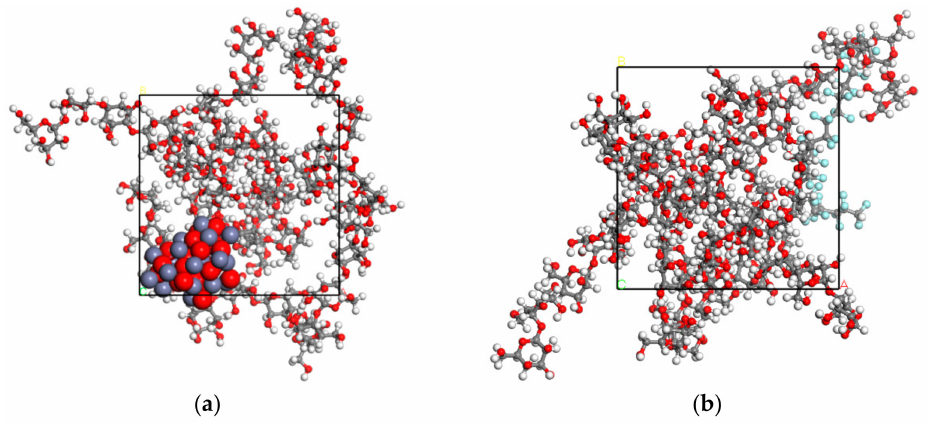
Figure 2. The optimized models of ( a ) a ZnO nanoparticle and cellulose, and ( b ) a PTFE nanoparticle and cellulose.